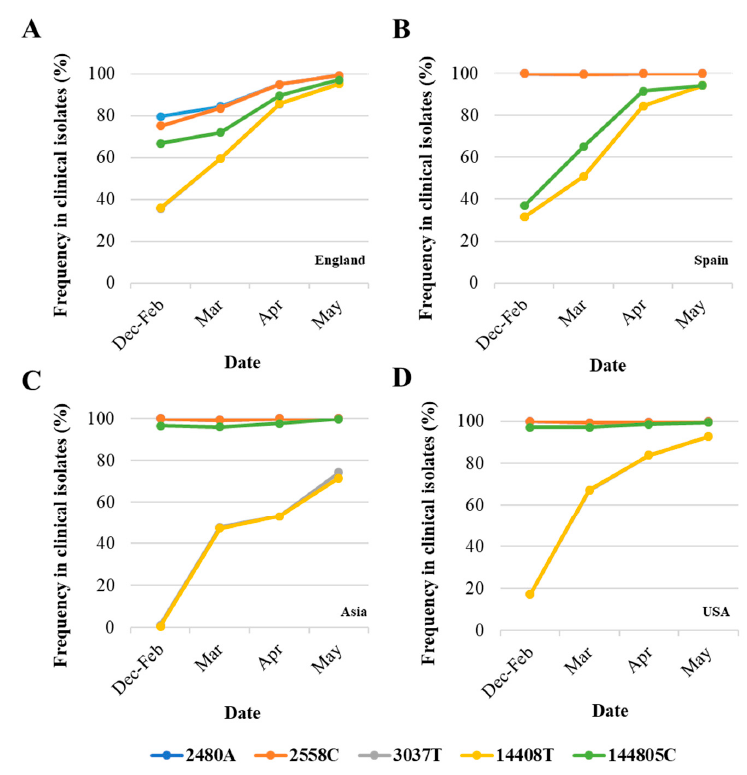
Figure 2. Changes in nucleotide sequence frequency at five selected SARS-CoV-2 genomic positions during the coronavirus disease (COVID-19) pandemic. The frequencies of 2480A (blue), 2558C (orange), 3037T (grey), 14408T (yellow), and 14805C (green) in England ( A ), Spain ( B ), Asia ( C ), and USA ( D ) are shown. Lines for nucleotides 2480 and 2554 and those for nucleotides 3037 and 14,408 mostly overlap as they correspond to associated sequence variations. Whole-genome SARS-CoV-2 sequences used in this analysis were downloaded from the GISAID database [48].